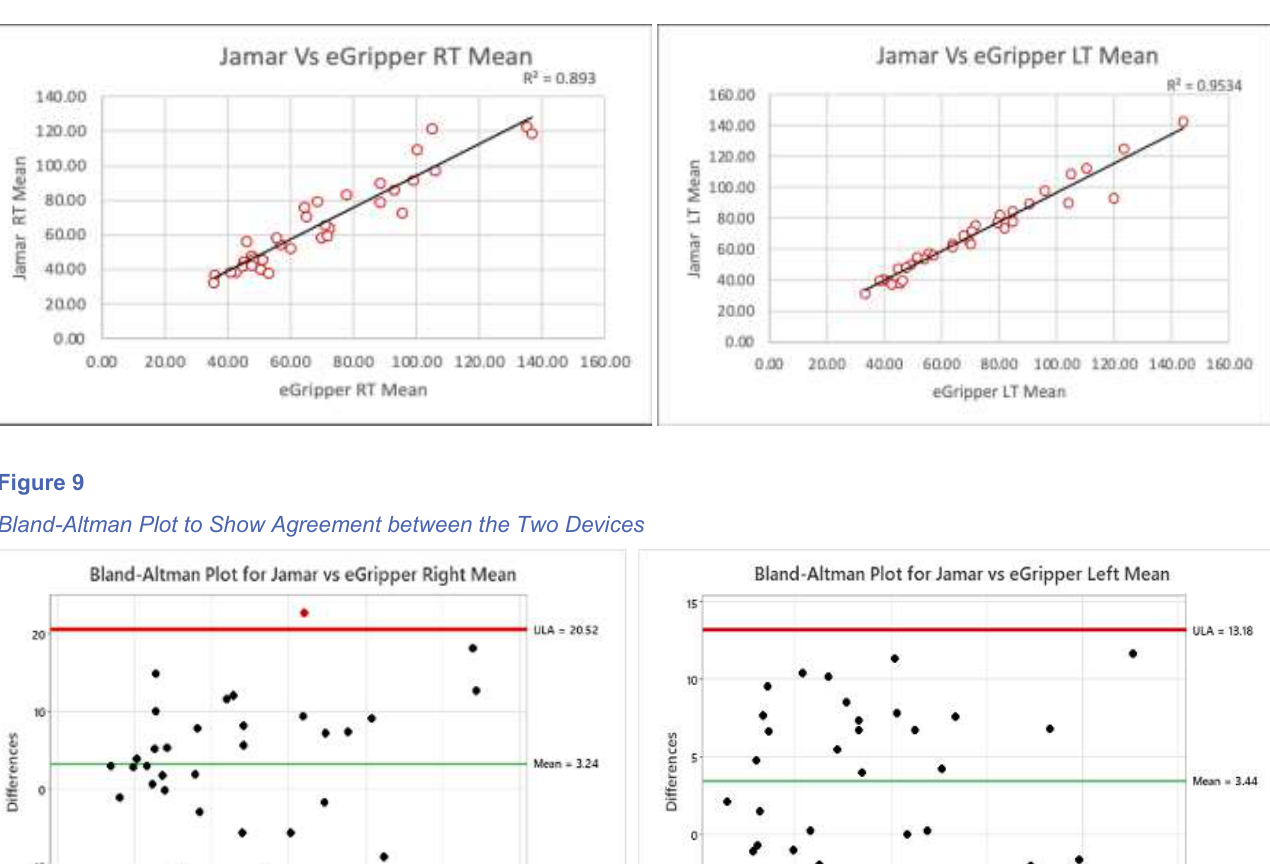
Figure 8 Linear Regression between eGripper and Jamar Dynamometer - Right and Left